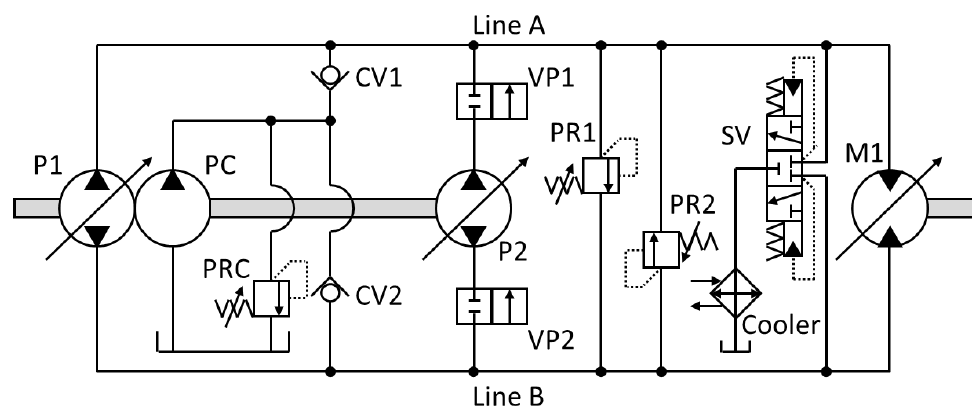
8 of 26 Figure 4. HT Operating Range: Reference (Left) vs. Solution A (Right). 3.3. Solution B Similar to Solution A, Solution B also uses two pumps and one two-position motor.